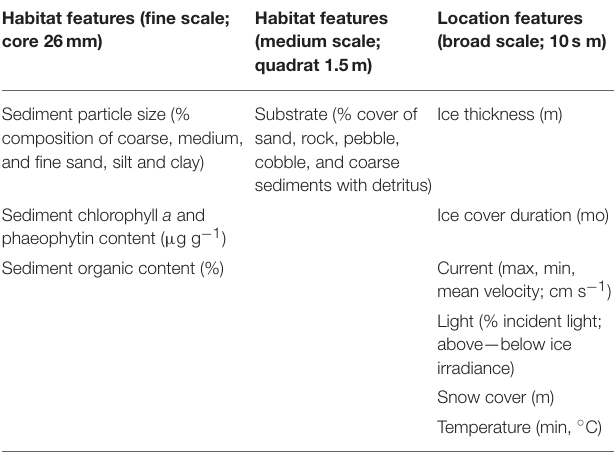
TABLE 2 | Environmental variables assessed at each site, and the scales at which they were observed. Habitat features (fine scale; core